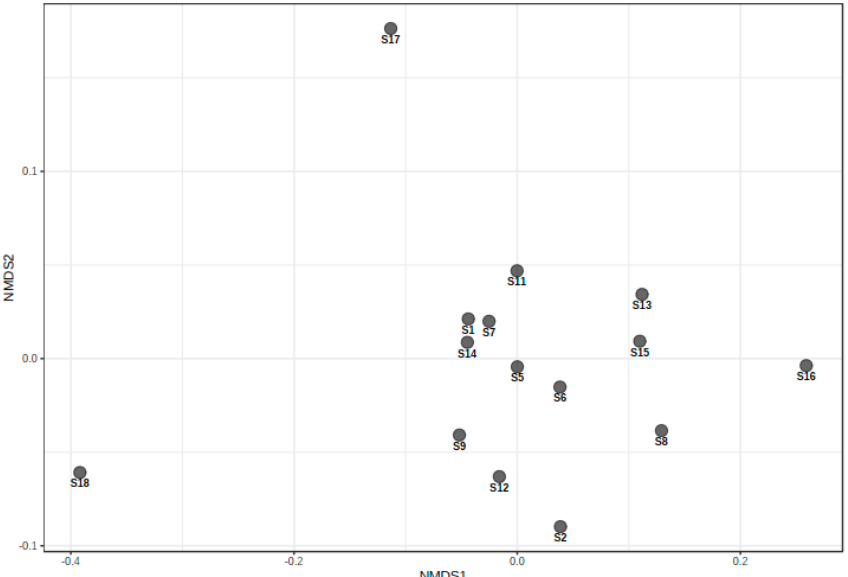
Figure 5. The NMDS diagram shows the beta-diversity of microbe communities among 15 soybean fields sampled from the Highveld region, Mpumalanga province, South Africa. The statistical method used to analyze group similarities was ANOSIM ( p < 0.85) and applied a Bray-Curtis dis- similarity distance distribution with the sample sites using a correction of R = −